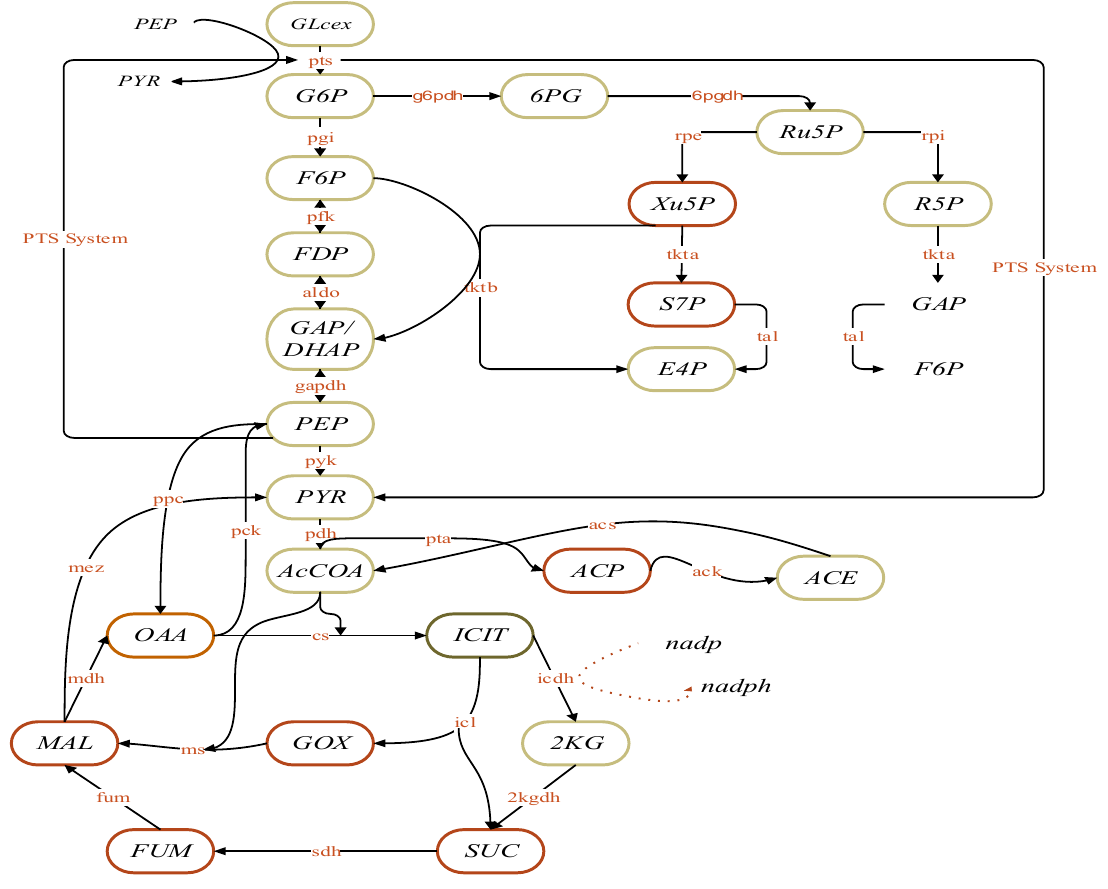
Figure 1. Main metabolic model of E. coli.